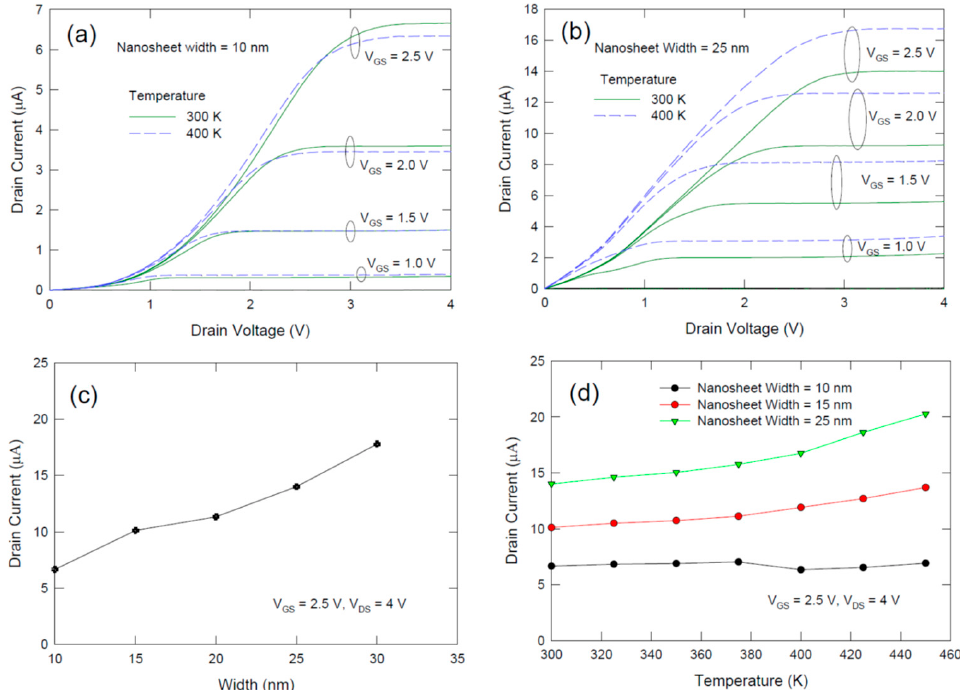
Figure 6. ( a ) Experimental current–voltage characteristics of a 10 nm width single layer nanosheet FET measured at 300 and 400 K; ( b ) current–voltage characteristics of 25 nm width nanosheet FET measured at 300 and 400 K; ( c ) plot of drain current as a function of sheet width; ( d ) temperature dependence of drain current for nanosheet FET with different sheet width. The gate length of the device was 2 μ m.